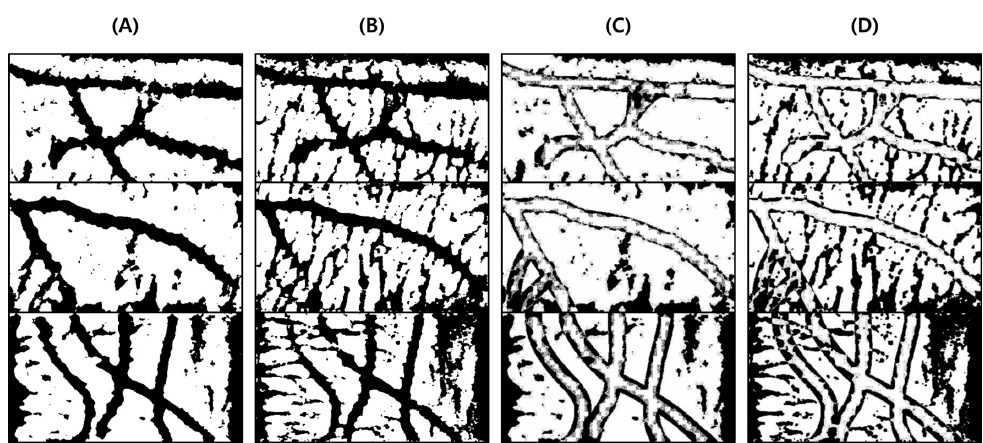
Figure 16. Result of applying SSIM to the results of the proposed algorithm and Veinvu-100 algorithm: ( A , B ) are binary images obtained by applying the proposed and Veinvu-100 algorithms, respectively, and ( C , D ) are the results of comparing ( A , B ) with the vascular layer using SSIM.